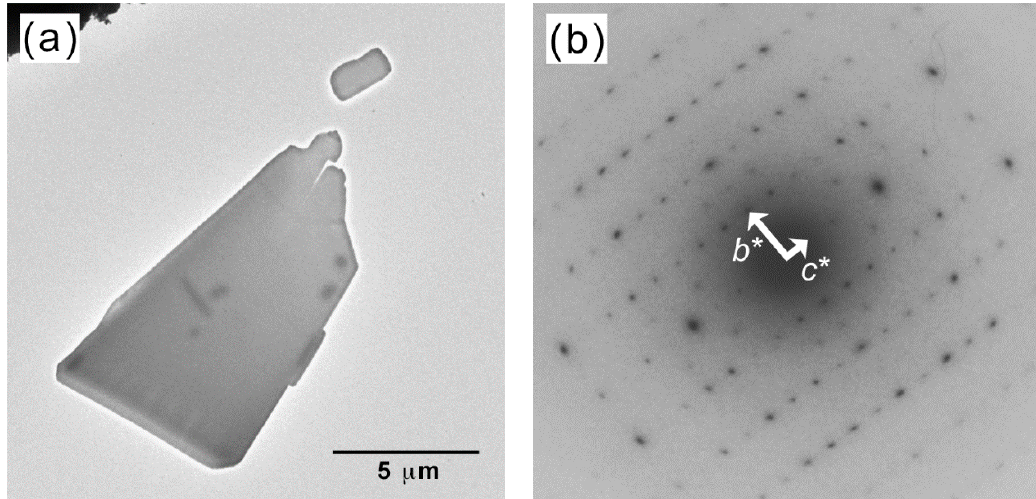
Figure 1. ( a ) Electron micrograph of a phenylphosphonic acid zinc (PPAZn) crystal, and ( b ) the corresponding diffraction pattern.